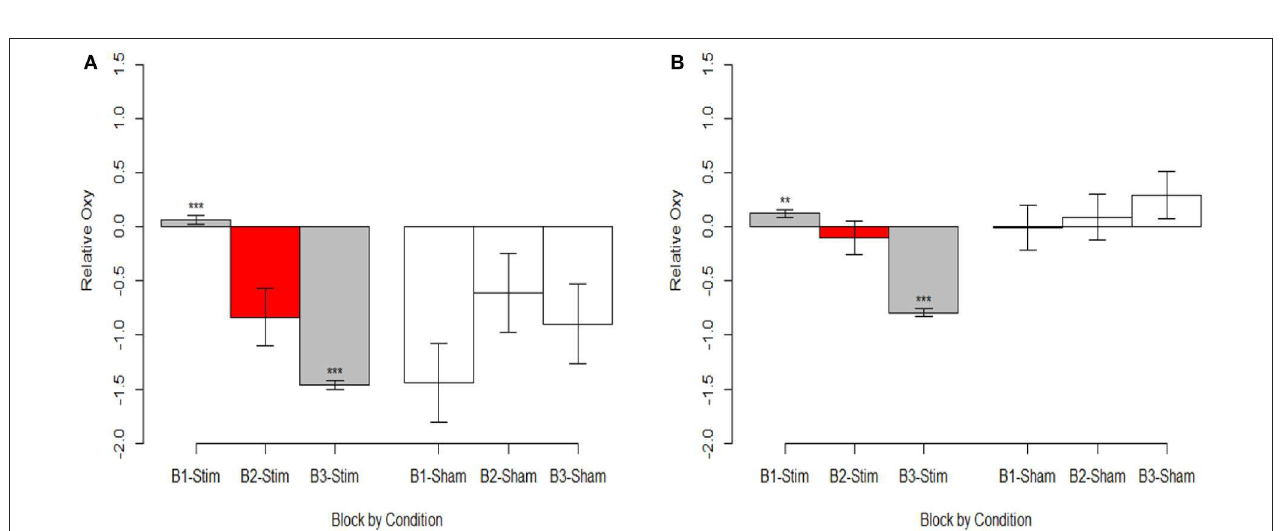
FIGURE 6 | Oxygenation at onset of hemodynamic response. (A) Optode 1 left dorsolateral BA 44/45. (B) Optode 15 right dorsolateral BA 44/45. Red bar represents comparison condition for dummy coding in mixed effects regression models. ** p < 0.01, *** p < 0.001.